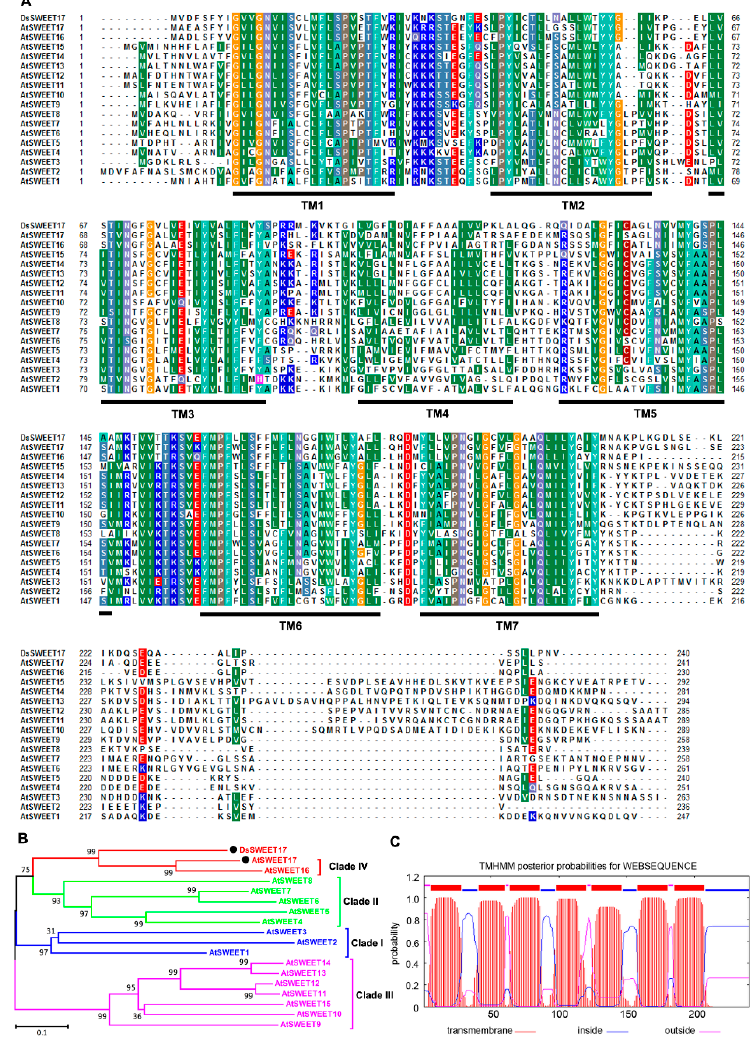
Figure 1. Analysis of DsSWEET17 sequence. Amino acid sequence alignment ( A ) and phylogenetic tree ( B ) of DsSWEET17 with other members (AtSWEET1 to AtSWEET17) of the AtSWEET family from Arabidopsis . ( A ) The same color residues indicate identical or highly similar residues in each sequence. ( C ) Putative transmembrane domains of DsSWEET17.